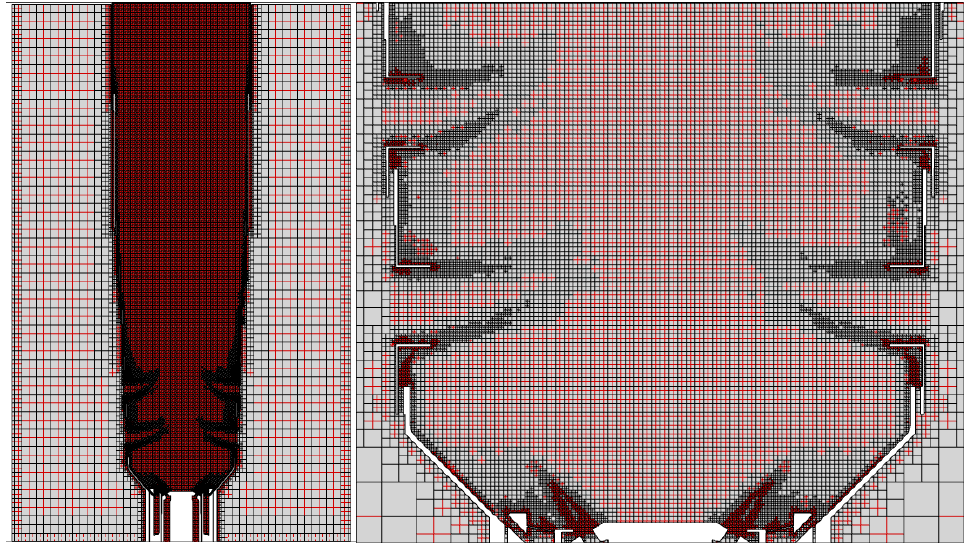
Figure 3. Base and refined mesh comparison.